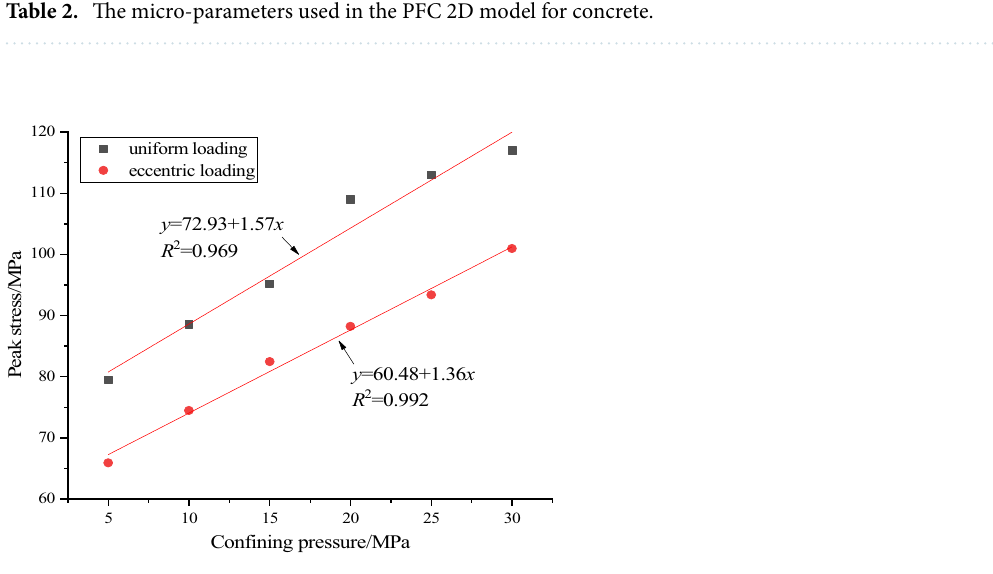
Figure 6. Effect of confining pressure on peak